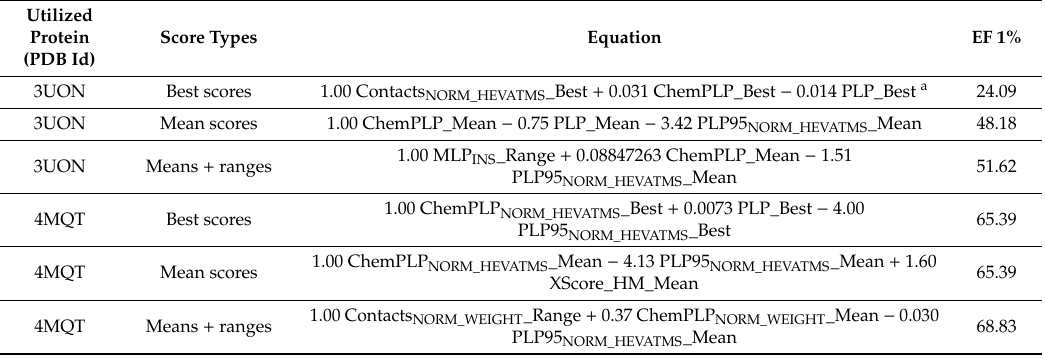
a For sake of clarity, the su ffi xes best, mean and range refer to best score value, score average and score range, respectively. Similarly, the subscripts NORM_HEVATMS and NORM_WEIGHT stand for normalized score values per the number of heavy atoms and weight, respectively.